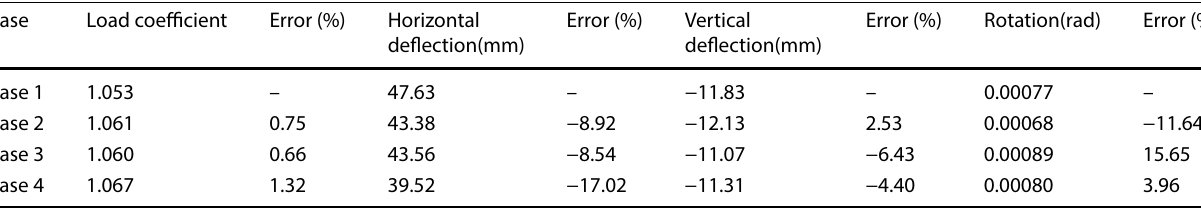
Table 5 Deflection at limit load at point B for nine-story